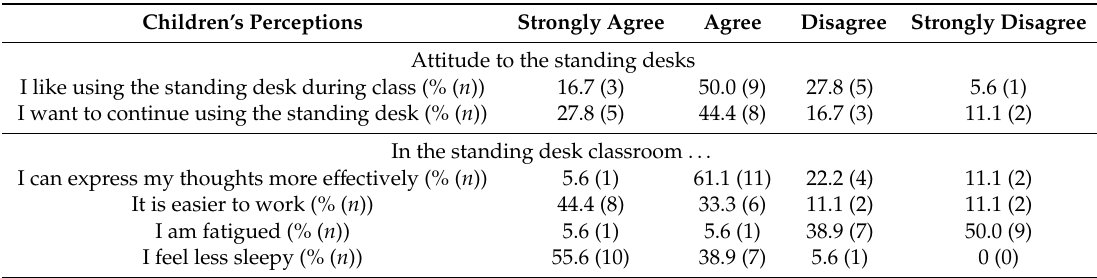
Table 1. Children’s perceptions of the standing desks.